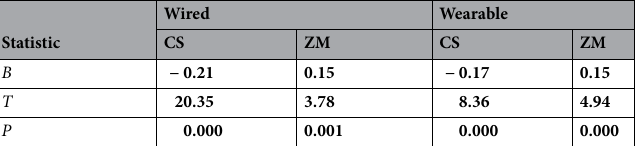
Table 1. Results of multilevel modeling of relationships between continuous valence ratings and facial electromyography data in Experiment 1. There were 14 degrees of freedom, as calculated by the m – l –